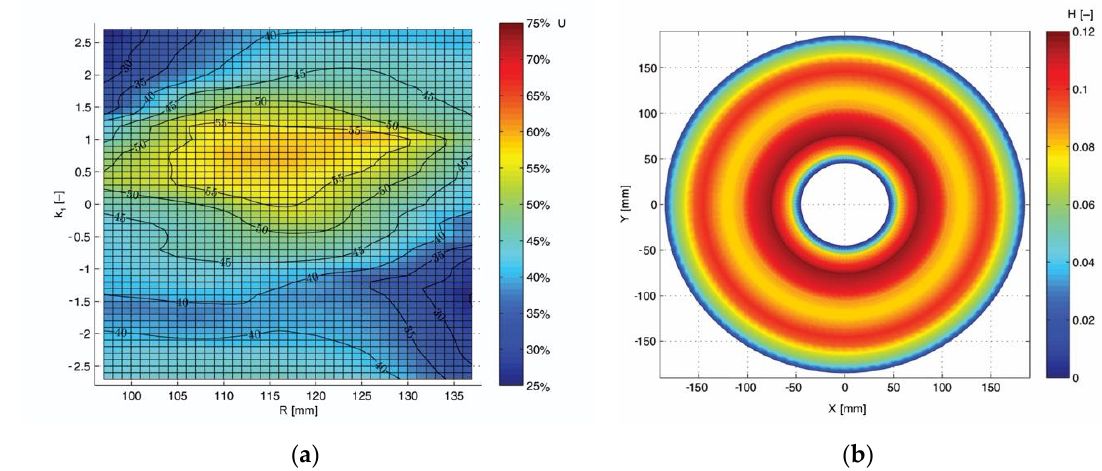
Figure 7. Simulation results: ( a ) distribution of the wear uniformity U with relative to the parameter k 1 and the radial position of the conditioning ring R ; and ( b ) distribution of the lapping plate wear for parameters R = 117 mm and k 1 = 7/9.